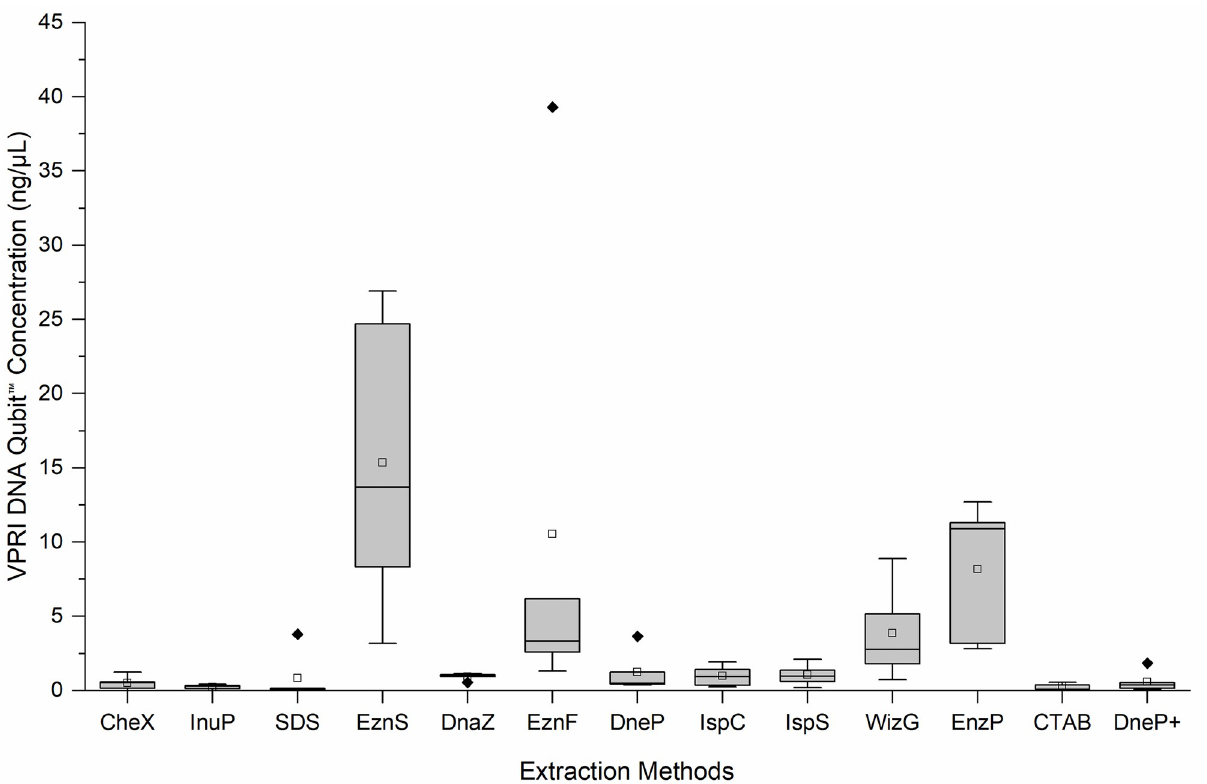
Fig 1. Boxplots of the DNA concentrations (ng/ μ L) of five victorian plant pathology herbarium (VPRI) apple powdery mildew specimens produced by 13 extraction protocols as measured by Invitrogen Qubit ™ fluorometer. Median line __ ; Mean □ ; Outlier ◆ Extraction method abbreviations: Chelex 1 100 (CheX), innuPrep Plant DNA (InuP), sodium dodecyl sulphate (SDS), E.Z.N.A. 1 SP Plant (EznS), DNAzol ™ (DnaZ), E.Z.N. A. 1 Forensic DNA (EznF), Qiagen DNeasy 1 Plant (DneP), Isolate II Plant DNA Lysis buffer PA1 C (IspC), Isolate II Plant DNA Lysis buffer PA2 S (IspS), Wizard 1 Genomic DNA Purification (WizG), E.Z.N.A. 1 Plant (EznP), Cetyl trimethyl ammonium bromide (CTAB) and Qiagen DNeasy 1 Plant plus PTB